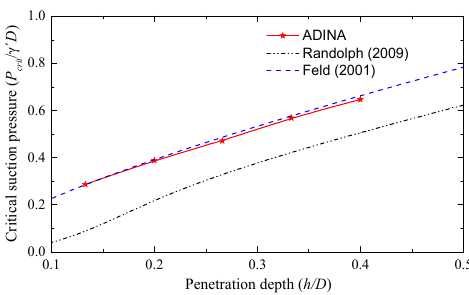
Figure 14. Relationship between the critical suction and penetration depth.